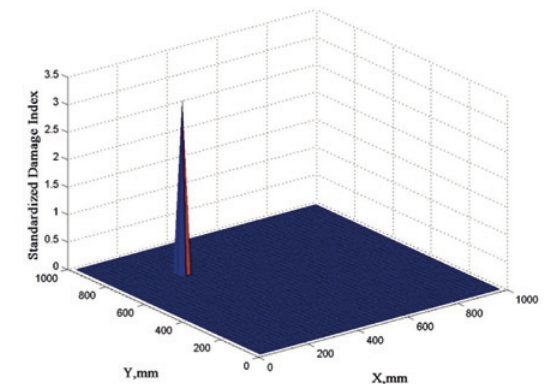
fig. 8. Standardised MSCSM damage index for test case 2.4 after truncation